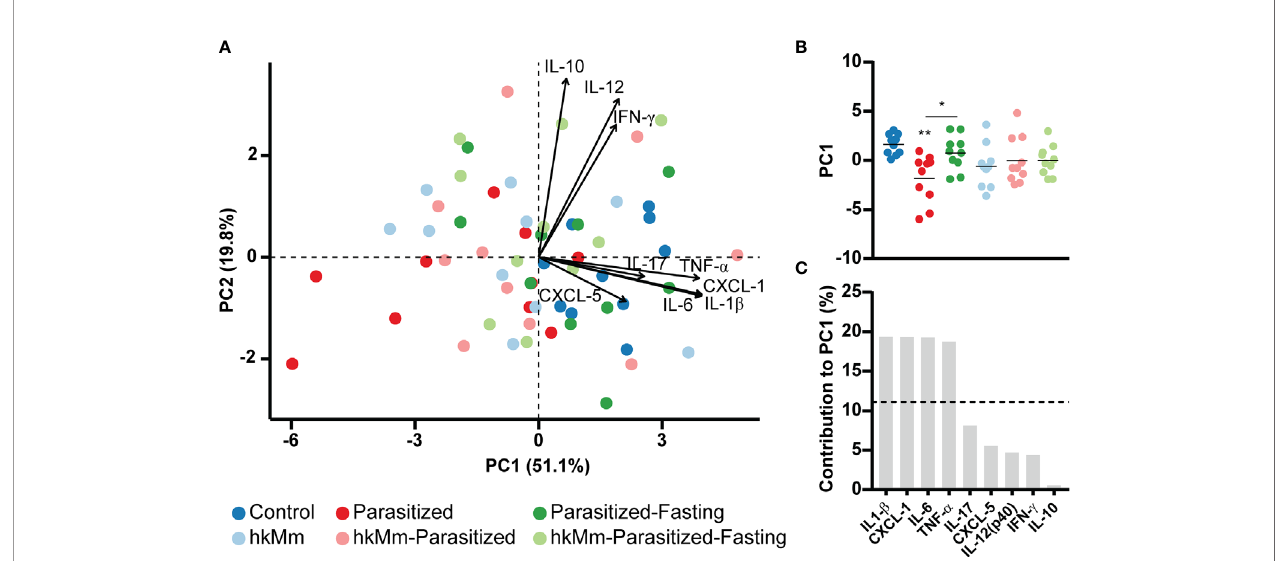
FIGURE 6 | Immune mediator analysis at week 3 post-infection. (A) PCA based on cytokines concentration in lung homogenates. (B) PC1 scores, each circle represents an animal and lines are means; ANOVA p -value=0.0067, Holm-Sidak ’ s multiple comparisons test (*p < 0.05, **p < 0.01). (C) Mediators contribution to PC1. hkMm, heat-killed M. manresensis